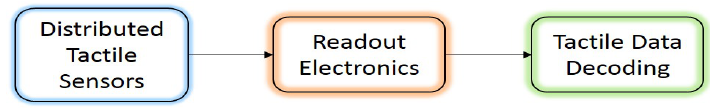
Figure 1. Block diagram of the tactile sensing